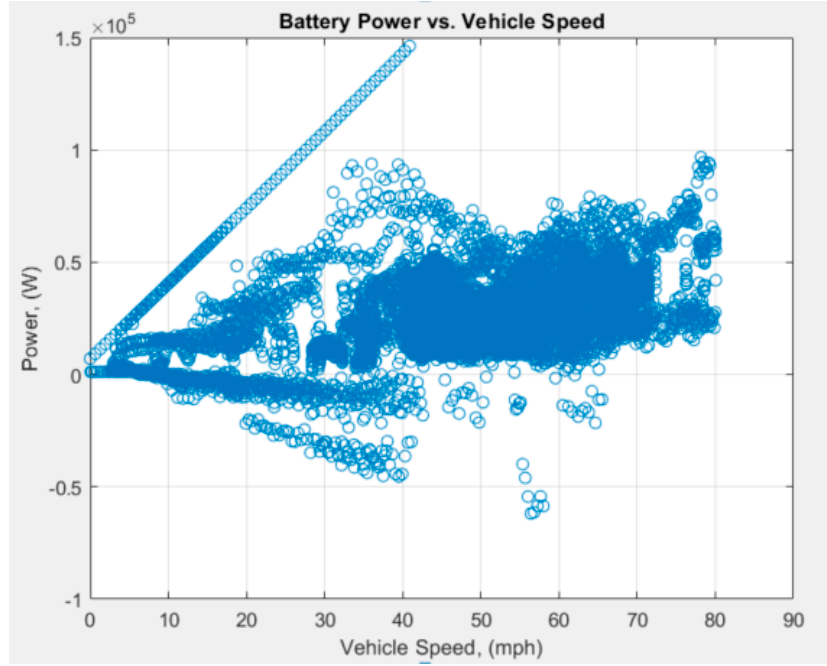
Figure 24. Motor power vs. speed for MCT drive cycle simulation.